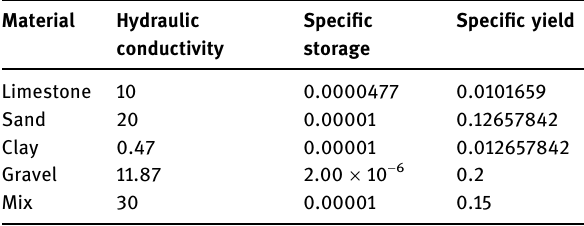
Table 6: Characteristics of the layers Material